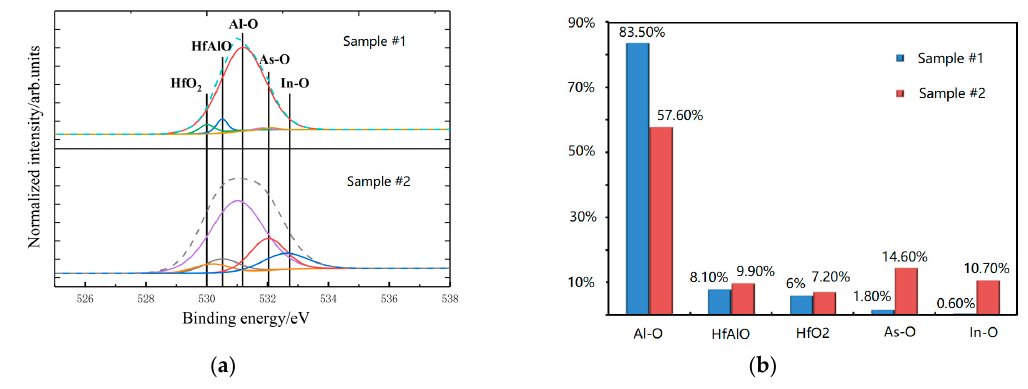
Figure 4. ( a ) X-ray photoelectron spectroscopy (XPS) measurement of the O 1s peak of the dielectric-semiconductor interface, ( b ) comparison of the ratio of various oxide contents on the interface.